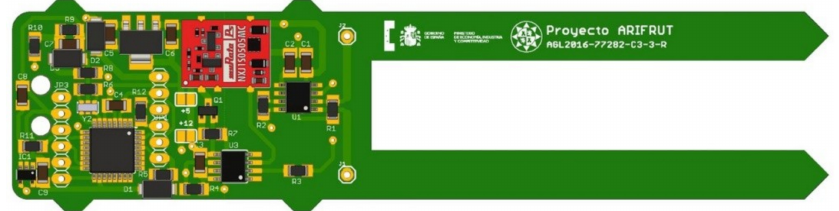
Figure 2. Experimental sensor